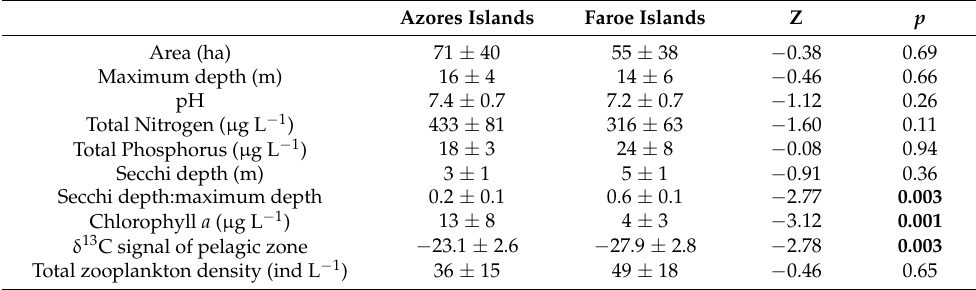
Table 2. Statistical comparison of the main lake characteristics between the two regions, indicating mean ± SE and results of statistical tests (Mann–Whitney tests).